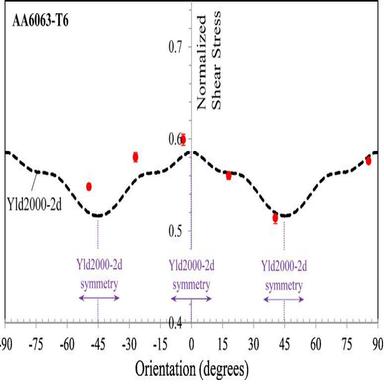
14. Shear anisotropy of AA6063-T6 extrusion and prediction of the Yld2000-2d yield criterion with respect to the extrusion direction. Red symbols show the experimental data. The Yld2000-2d yield criterion is applicable for orthotropic-symmetric materials and has a symmetric response with a frequency of 45° in shear.